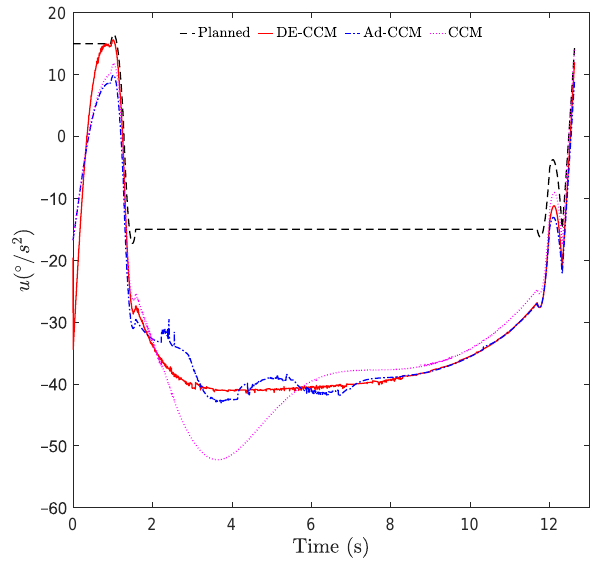
Figure 4. Control inputs yielded by different